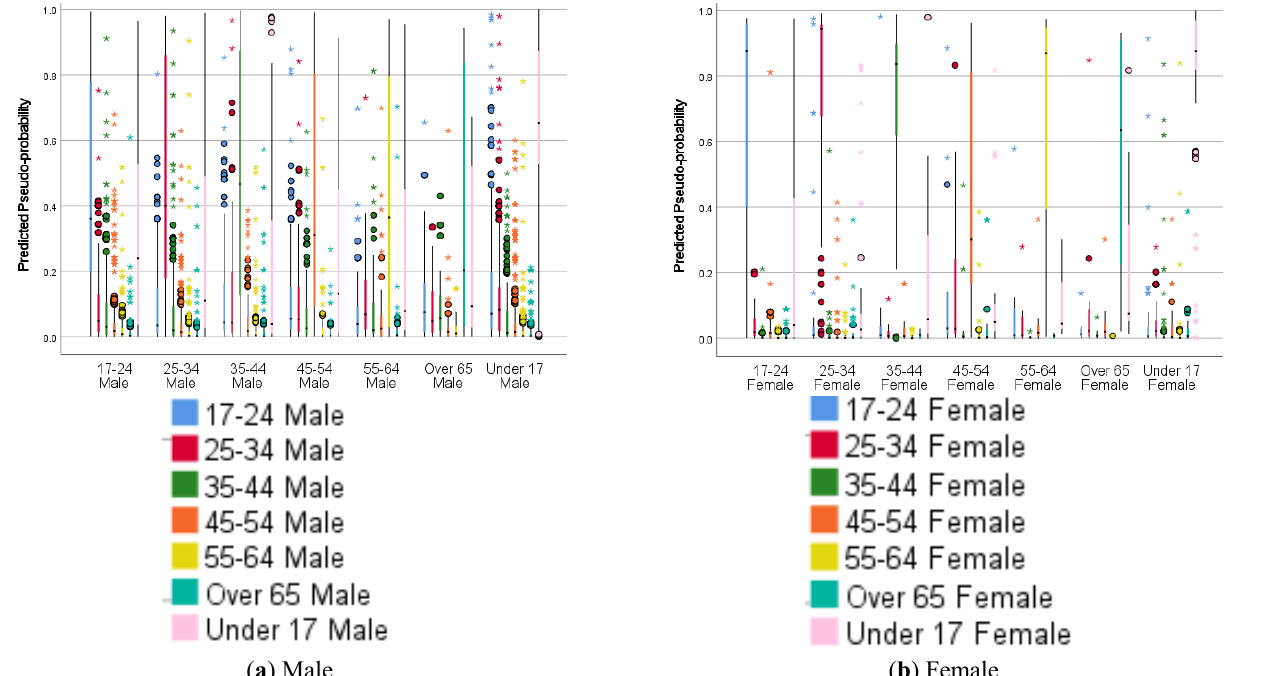
Figure 3. The predicted by observed for each output variable of: ( a ) male, ( b ) female.